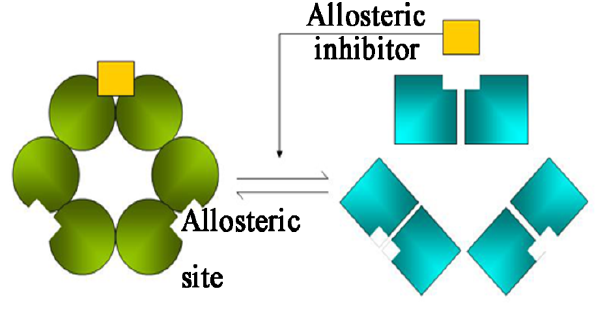
Figure 10. Cooperativity: a cartoon representation of the Monod–Wyman–Changeux model of allosteric transitions. Three binding sites for 12 Cl − and three pairs of catalytic triads in PH1704 are observed. The activity of PH1704 is directly under allosteric control via the bound Cl −